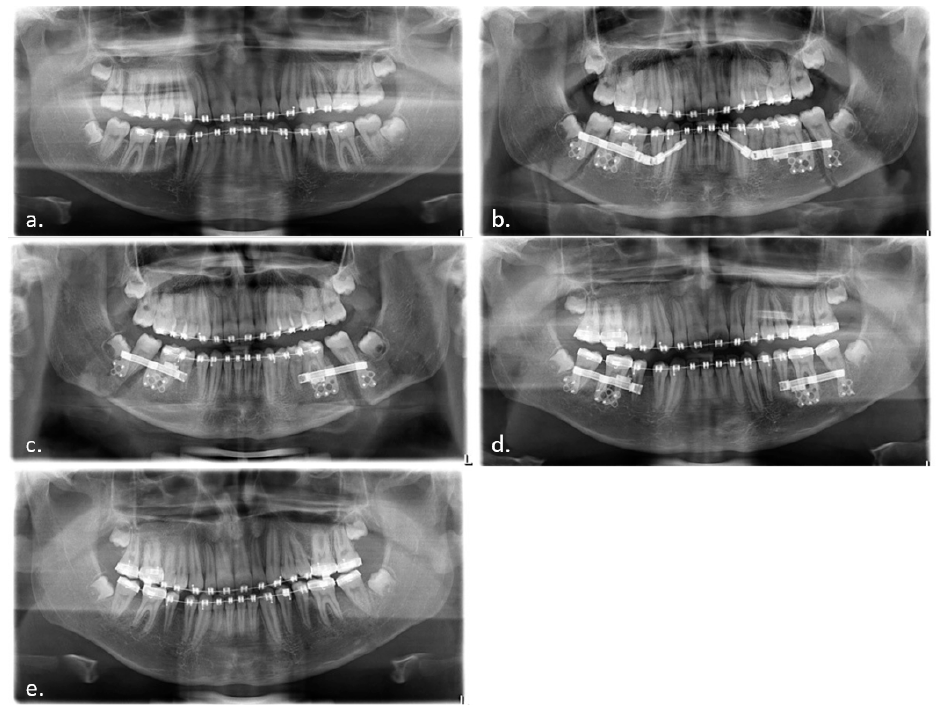
Figure 3. Radiological follow-up. Panoramic X-rays: ( a ) Before IMDO. Note the small diastema between the first and second molars of the mandible. ( b ) Control after distractor placement. Note the symmetrical axis tilt of the distractors. ( c ) End of active distraction treatment and removal of activation rods for more patient comfort. ( d ) Bone consolidation 10 weeks after end of distractor activation. ( e ) After removal of the distractors.